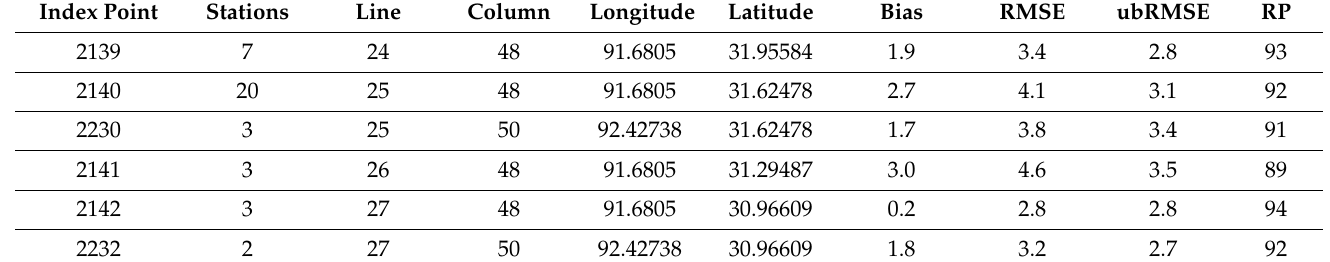
Table 1. Satellite (SPL3SMP_36km) and ground-measured SSM comparisons at the validation sites on the Tibetan Plateau, including all the datasets from 1 April 2015 to September 2016. Units are in m 3 /m 3 .